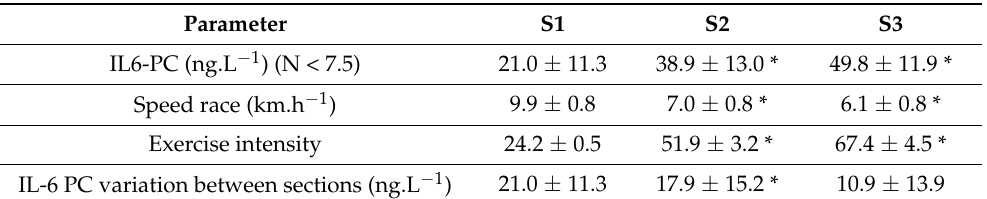
Table 1. Values of IL-6 PC, speed race within section, IL-6 plasma concentration variation between sections. Data are expressed as mean ±